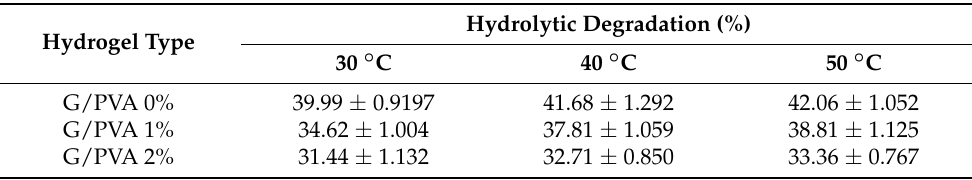
Table 6. The rate of hydrolytic degradation (HD) of gelatin and gelatin/PVA hydrogels was deter- mined after 24 h of incubation at different